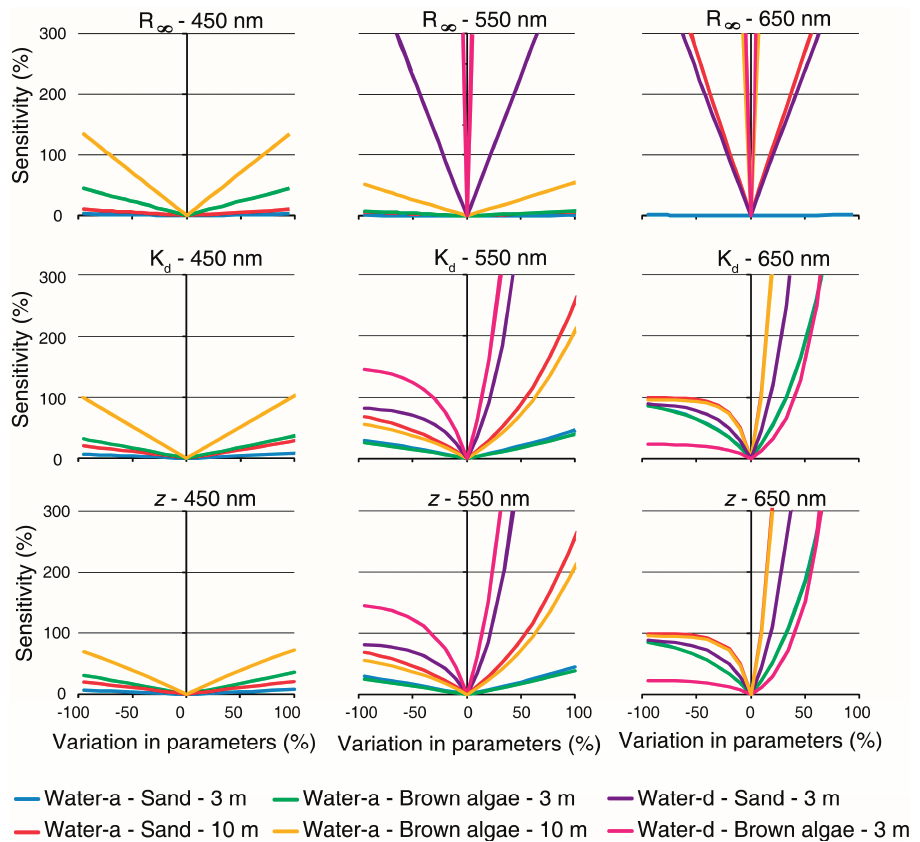
Figure 7. Sensitivity analyses for parameters of M94: (cid:1844) sensitivity (in %) defined in Equation (14). Results are arranged by parameter and wavelength (450, 550 and 650